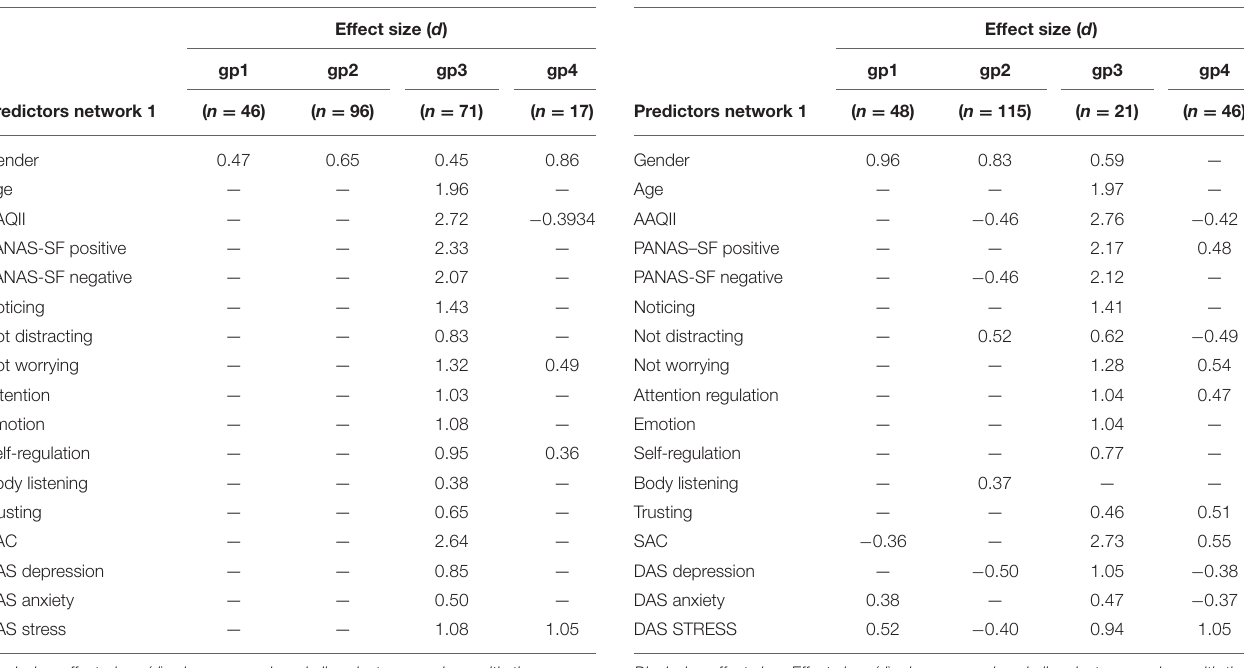
TABLE 10 | Network 2, including just the DIF outcome. TABLE 11 | Network 4, including just the EOT